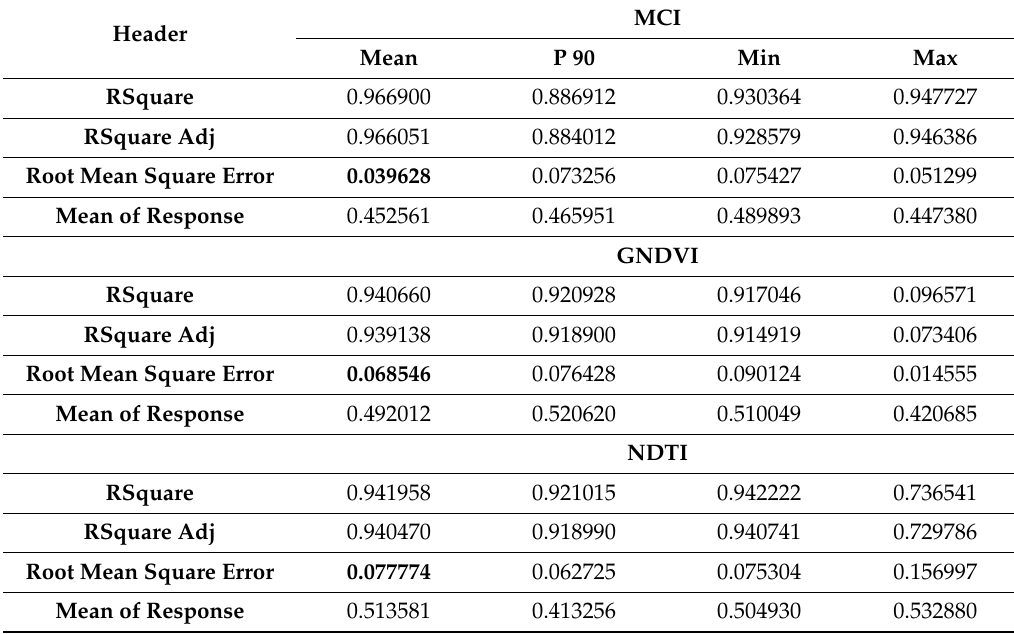
Table 1. Summary of fit analysis.